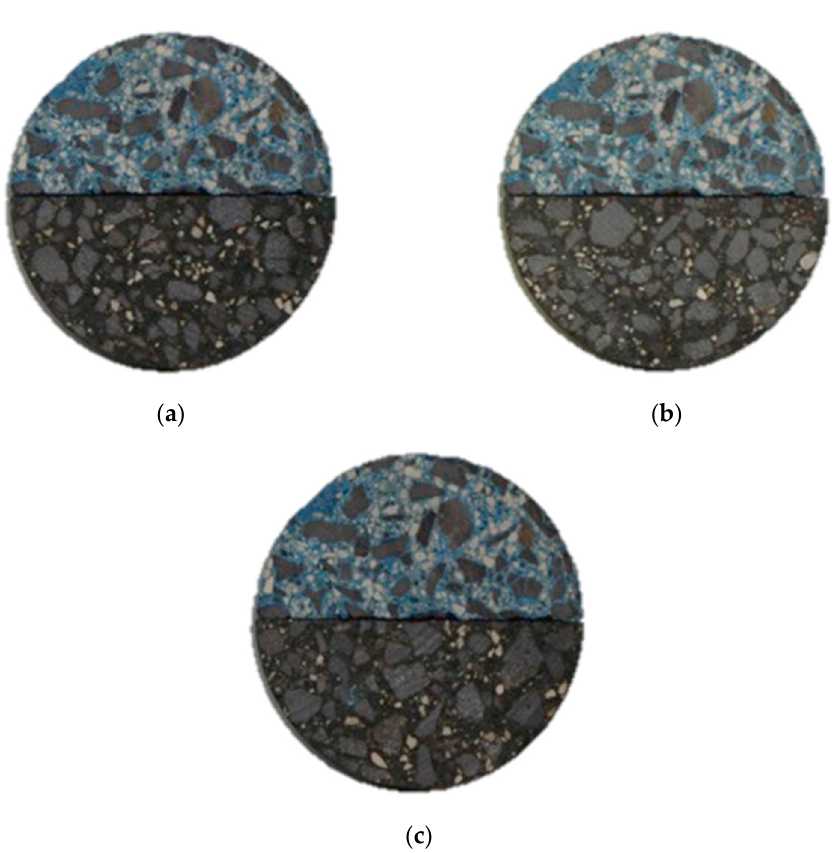
Figure 4. Blue specimens half ‐ cut view of bituminous mixtures without RAP and RAP mixtures: a ) 0RAPH ‐ 75RAPH; b ) 0RAPH ‐ 75RAPL; c ) 0RAPH ‐ 75RAPLR.